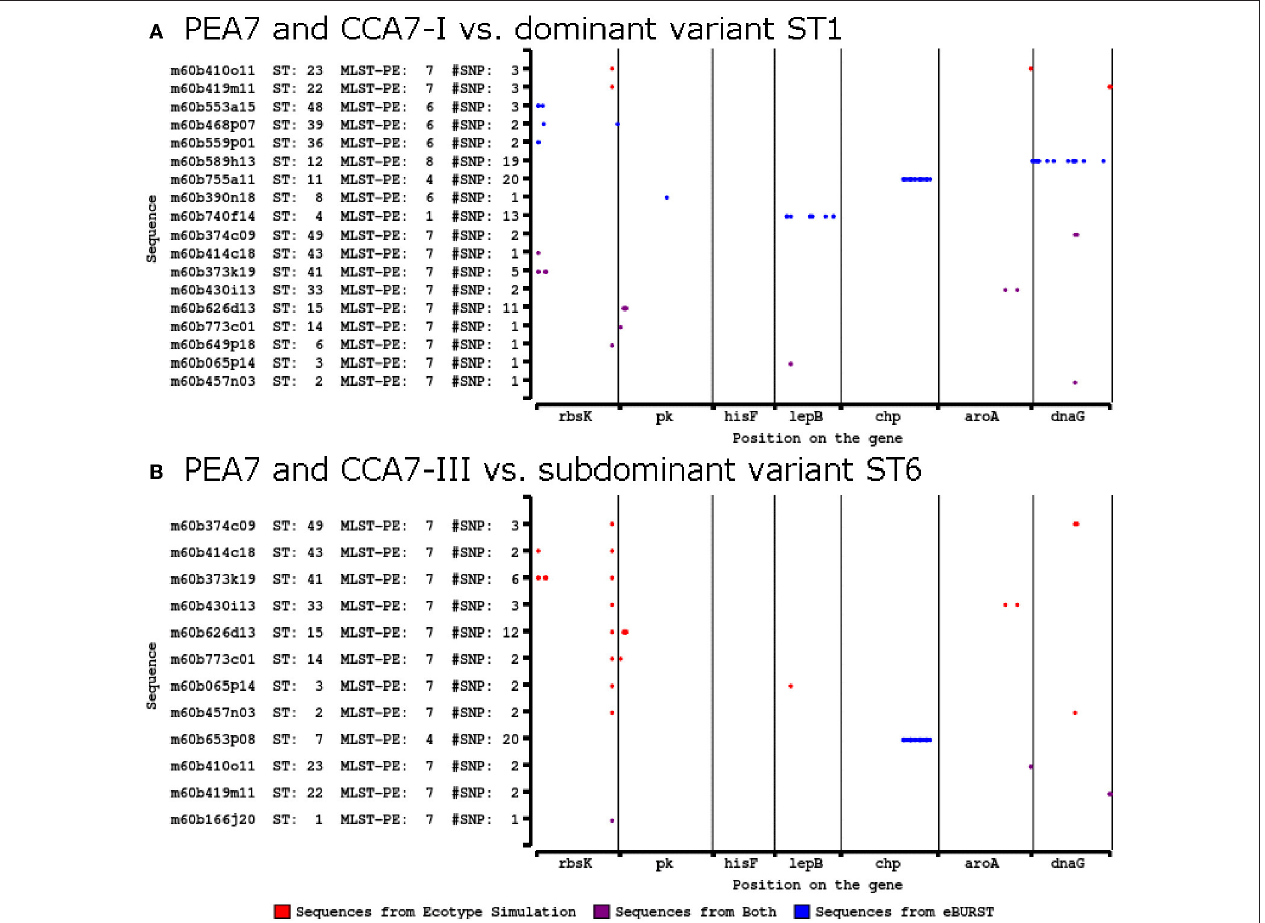
FIGURE 5 | Single nucleotide polymorphism patterning of A-like Synechococcus BACs grouped around the same dominant variant (also consensus sequence) by Ecotype Simulation and eBURST. Variants detected only by eBURST (blue), only by Ecotype Simulation (red) or by both (purple) are compared to the shared dominant variant (consensus sequence). (A) Dominant variant ST1 in PEA7 and clonal complex A7-I and (B) subdominant variant ST6 in PE7 and clonal complex A7-III. STs correspond with STs in Figure 2A .